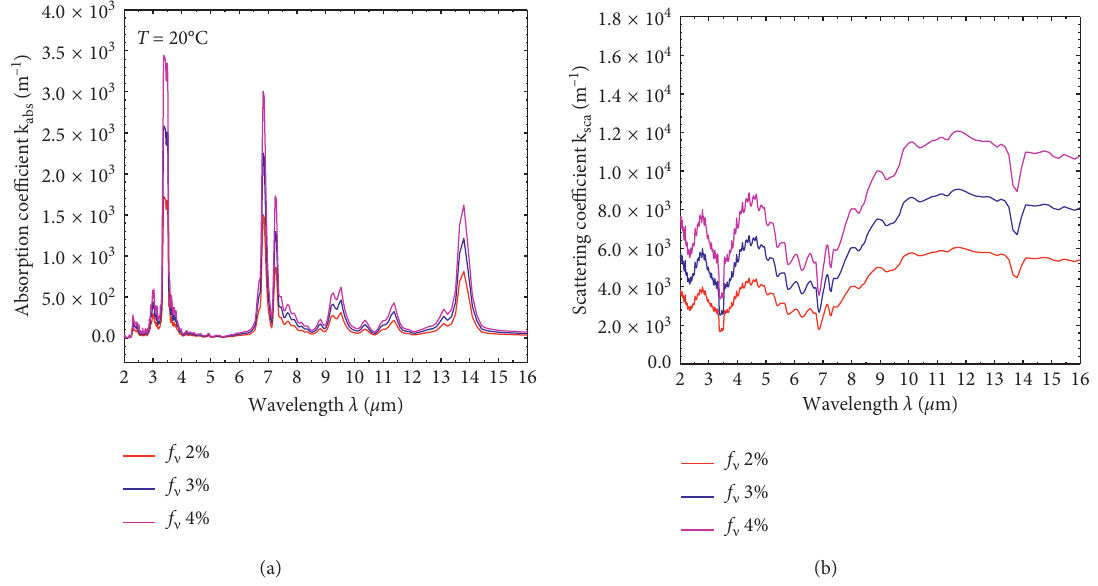
Figure 5: Absorption and scattering coefficients of the n-octane droplets-air system at 20 °